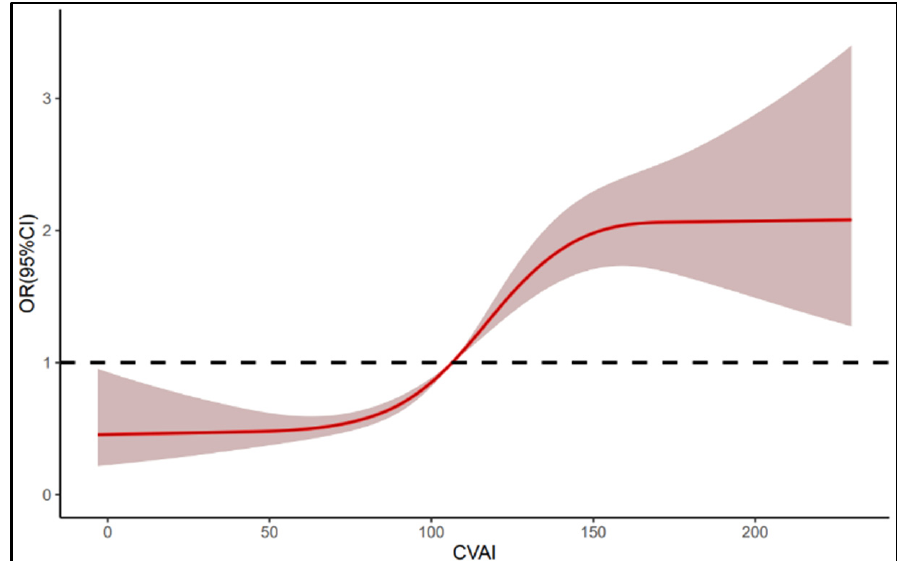
Figure 3. Dose–response relationship of CVAI and CAS risk. CVAI: Chinese Visceral Adiposity Index, CAS: carotid atherosclerosis, OR: odds ratio, CI: confidence interval.